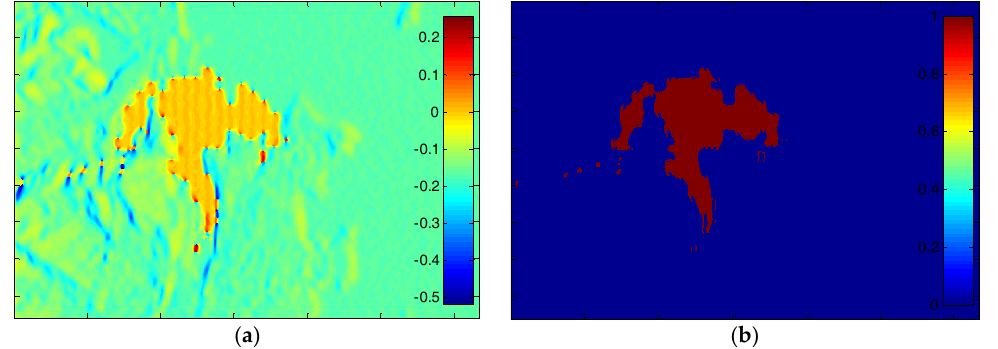
Figure 9. The frequency detection results: ( a ) Fourier transform of interferogram in the range direction; and ( b ) 0–1 valued mask.